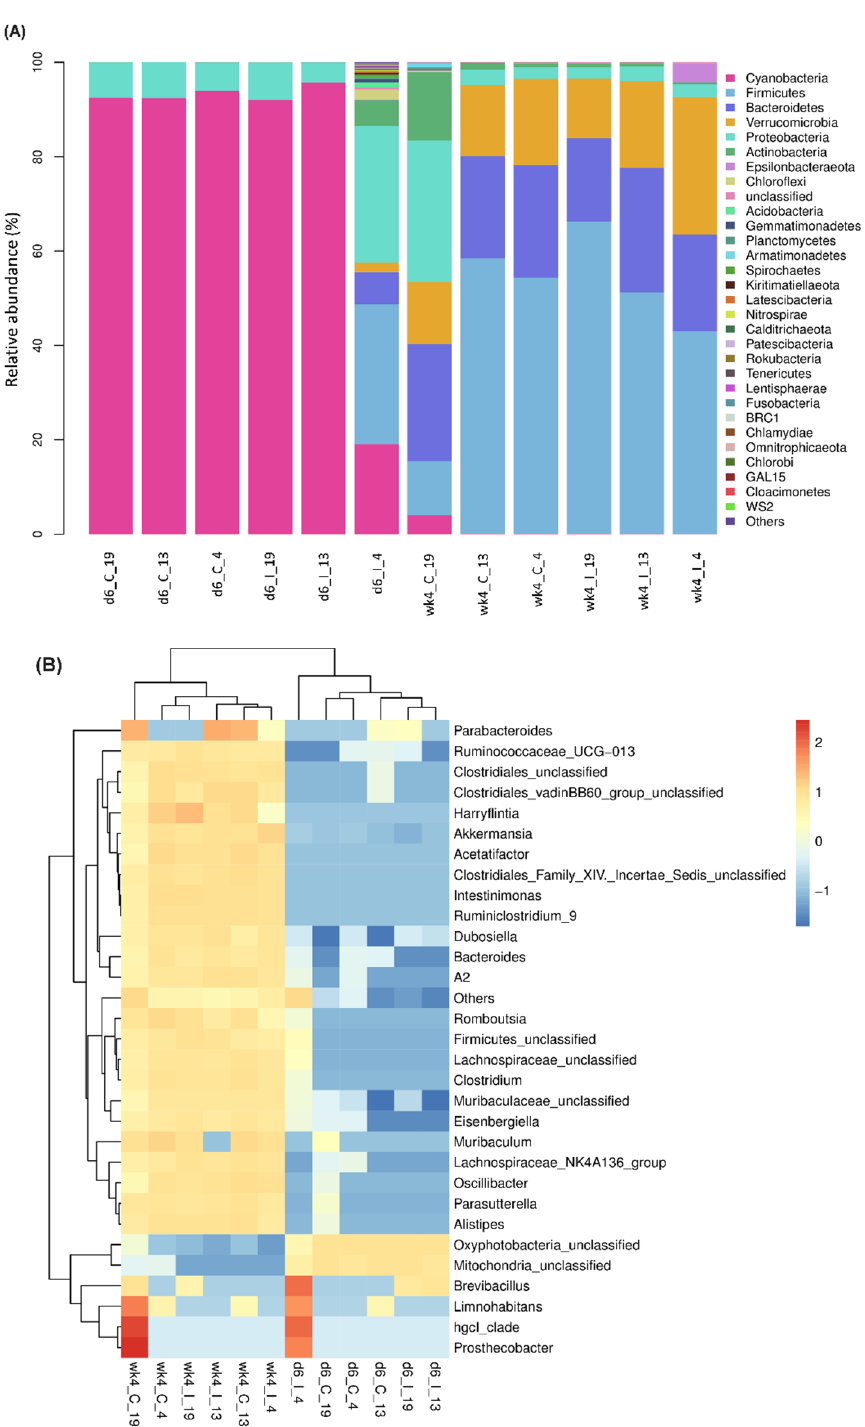
Figure 1. Bacterial phyla and genera were significantly altered among beet curly top virus (BCTV)- susceptible and BCTV-resistant sugar beet genotypes. Mean relative abundance of ( A ) prokaryote phyla; and ( B ) genera in the leaves at early (day 6; d6) and late (week 4; wk4) time points with or without BCTV infection. 19, susceptible genotype; 13 and 4, resistant genotypes. C = uninfected control, and I = BCTV-infected. The data are mean ± standard error of four replicates (uninfected control) and five replicates